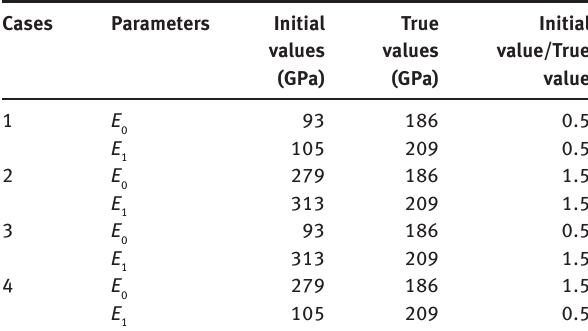
Table 7: Initial values of material parameter in a rectangular FGM plane